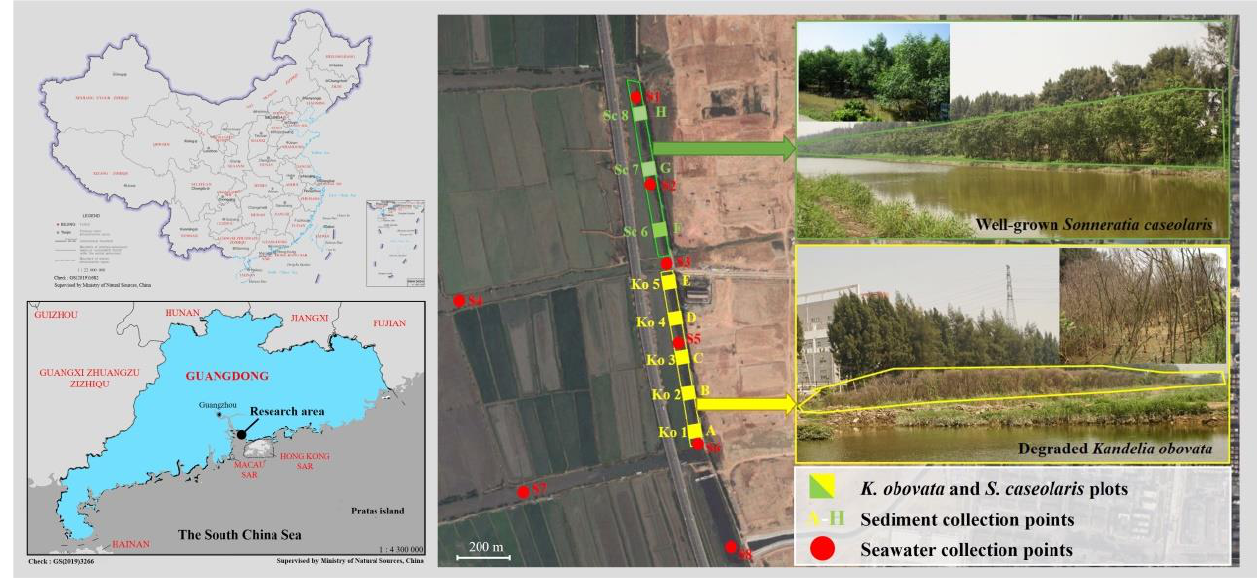
Figure 1. A combination figure of a collection map and two photographs showing the geographical research area of the planted forests of K. obovata (dead) and S. caseolaris (live) on the western coast of Bao ’ an, Shenzhen, China.